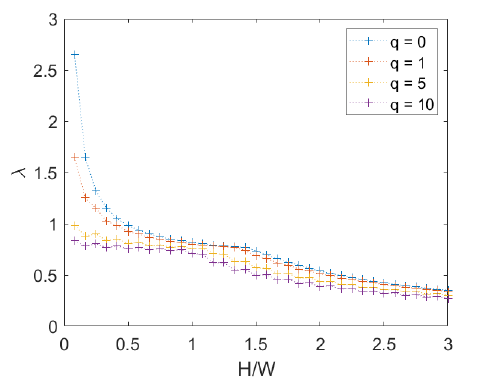
Figure 15. Periodic masonry: failure multiplier for c = 1 and several set of loads q .